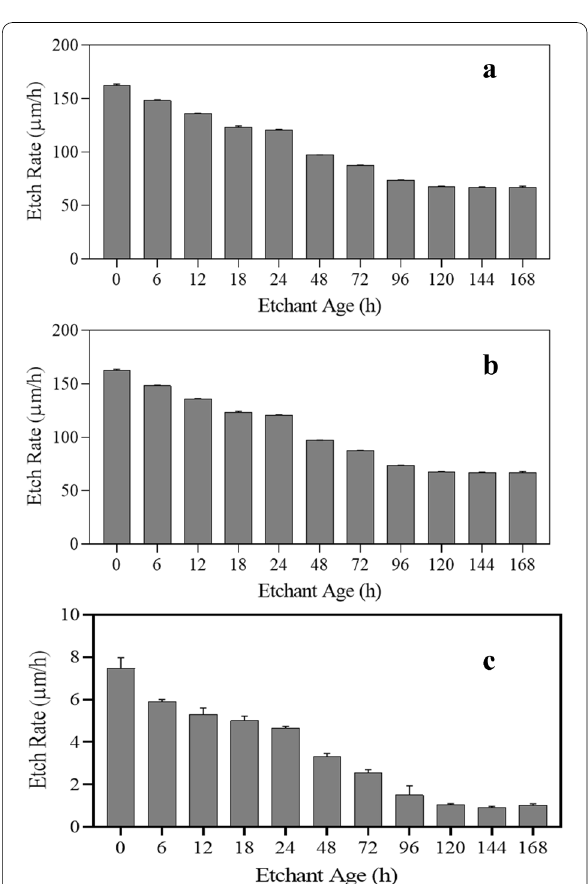
20 wt% KOH on the etch + 1 °C ±